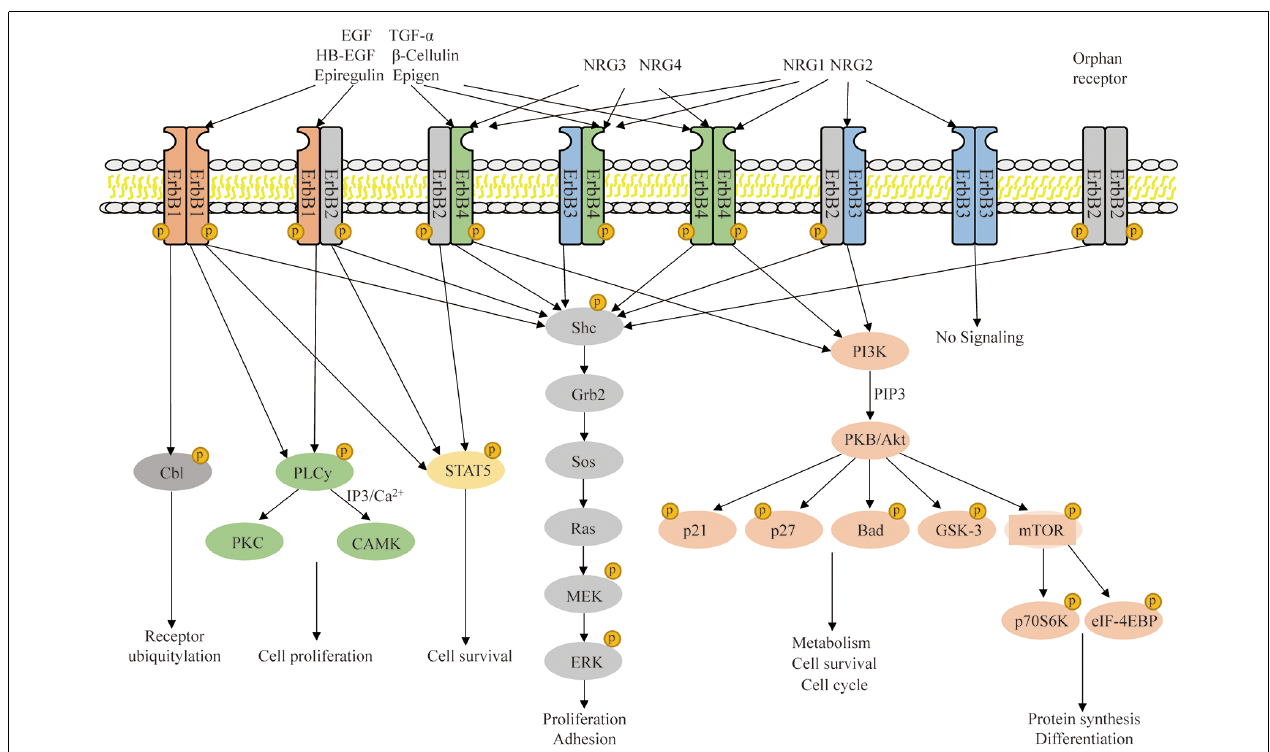
FIGURE 2 | NRG/ErbB signaling and downstream signaling pathway. The NRG1–4 ligand interaction with ErbB1–4 increases their affinity and induces homodimerization and heterodimerization of ErbB1–4, thus activating the tyrosine kinase domain and allowing the phosphorylated activation of ErbB receptorsin the cytoplasmic region. These processes regulate multiple intercellular signal transduction and participate in a wide range of biological processes in the nervous system.